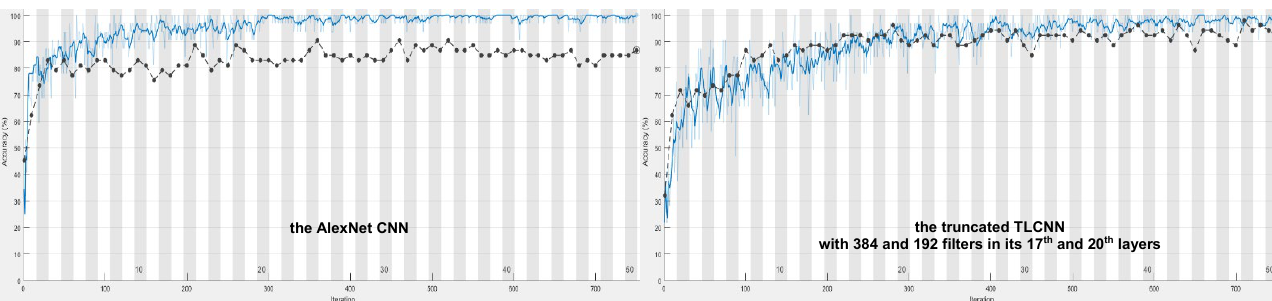
Fig. 13. The training progress of the AlexNet CNN (202.39 MB) against a TLCNN (21.57 MB) for the task by Fig. 11. The TLCNN size reduction impact is 9.4.